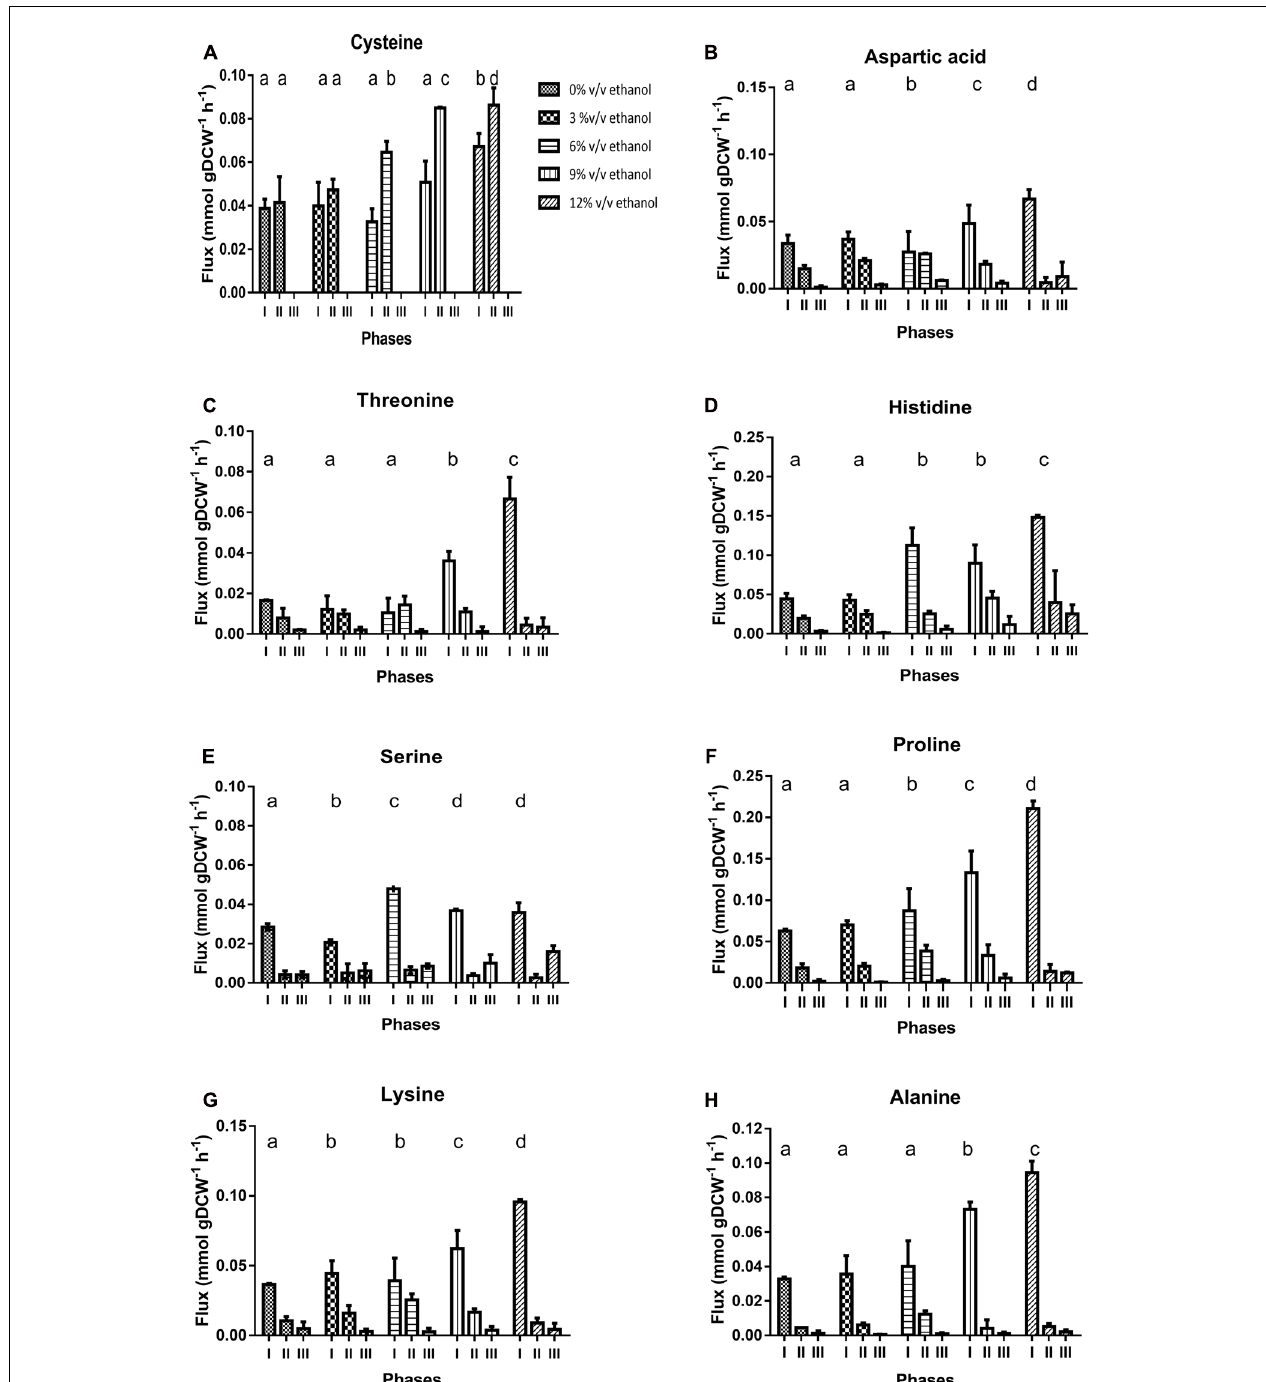
FIGURE 5 | Specific consumption rates of amino acids during cultivation of O. oeni PSU-1 under increasing ethanol contents. (A) Cysteine. (B) Aspartic acid. (C) Threonine. (D) Histidine. (E) Serine. (F) Proline. (G) Lysine. (H) Alanine. Statistical analysis was only performed for phase I and shared letters indicate no significant difference (Mood test, p <